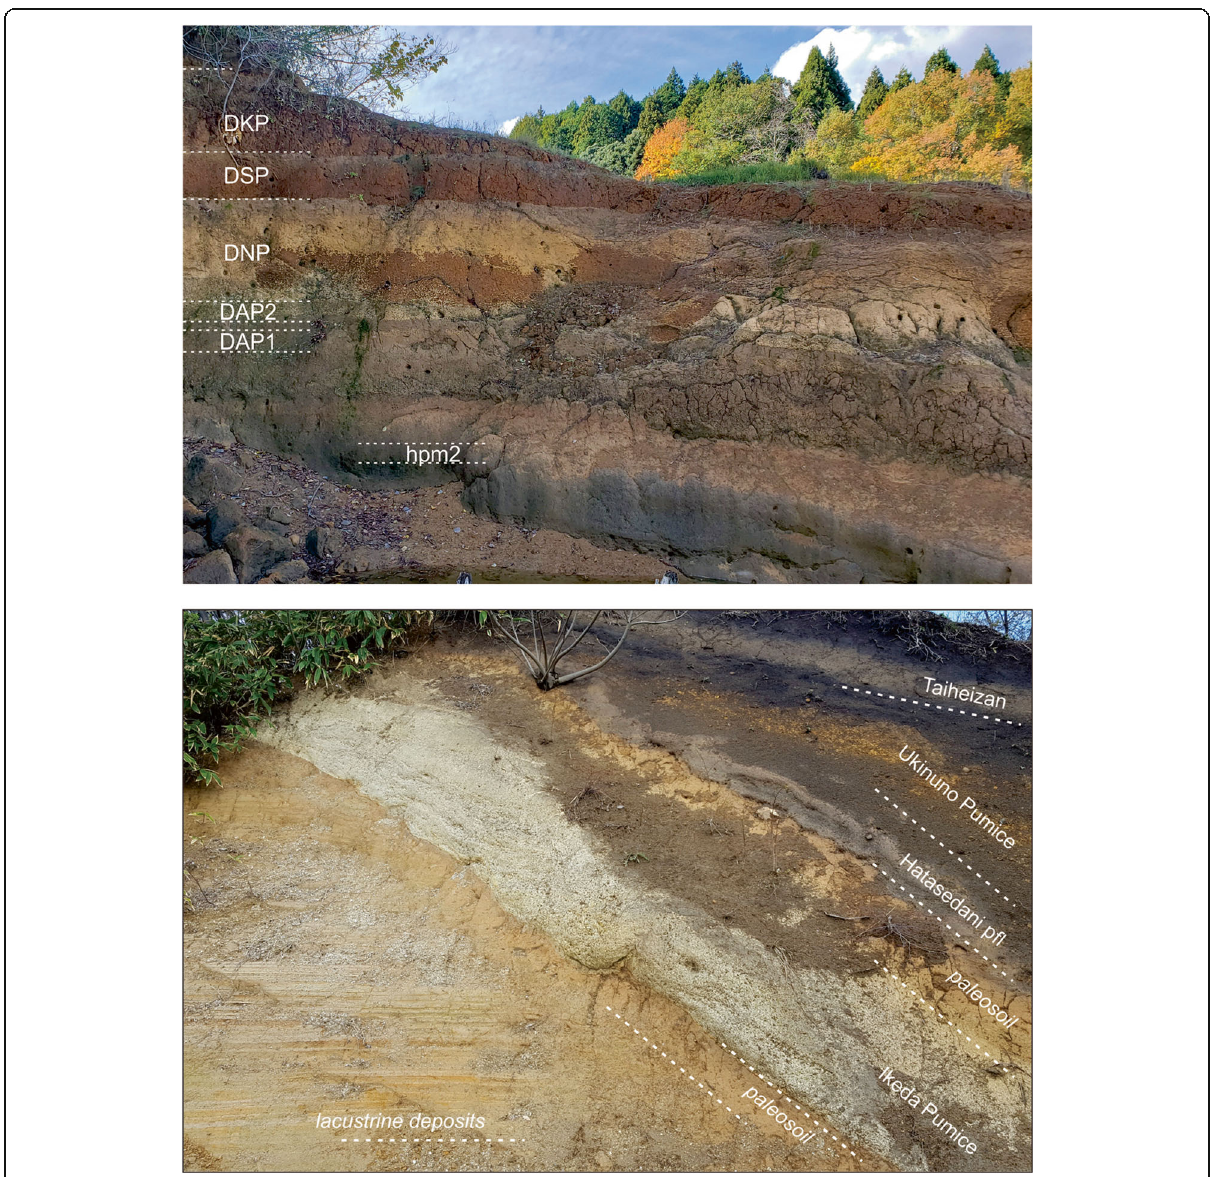
Fig. 16 Two representative outcrops, showing the field occurrence of tephras at Daisen (top) and Sanbe (bottom) volcano (for stratigraphic position, refer to Fig.